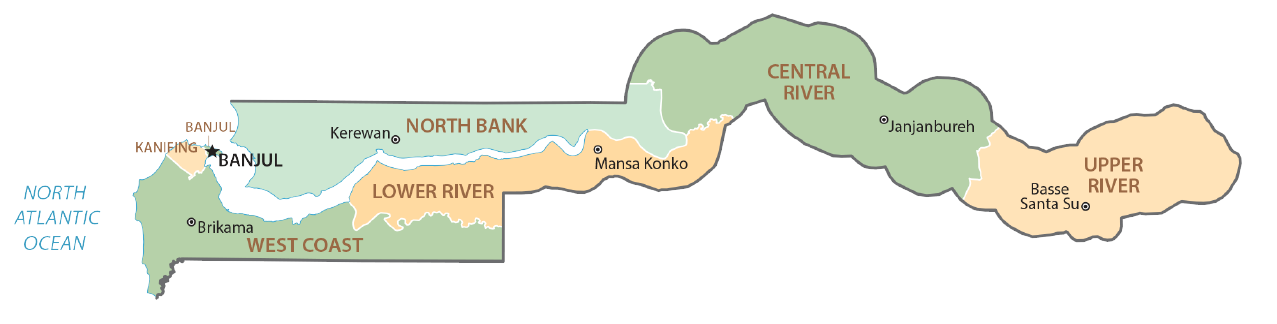
Figure 2. Map of The Gambia showing five administrative regions. Source: